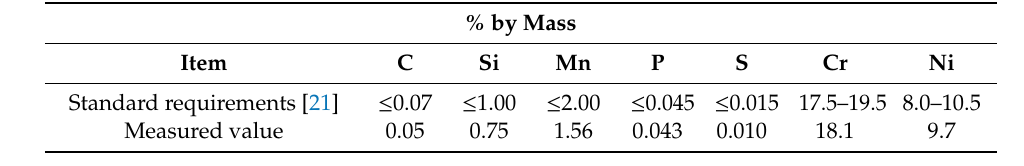
Table 1. Chemical composition of austenitic steel 1.4301 (X5CrNi18-10) according to [21] and measured value.